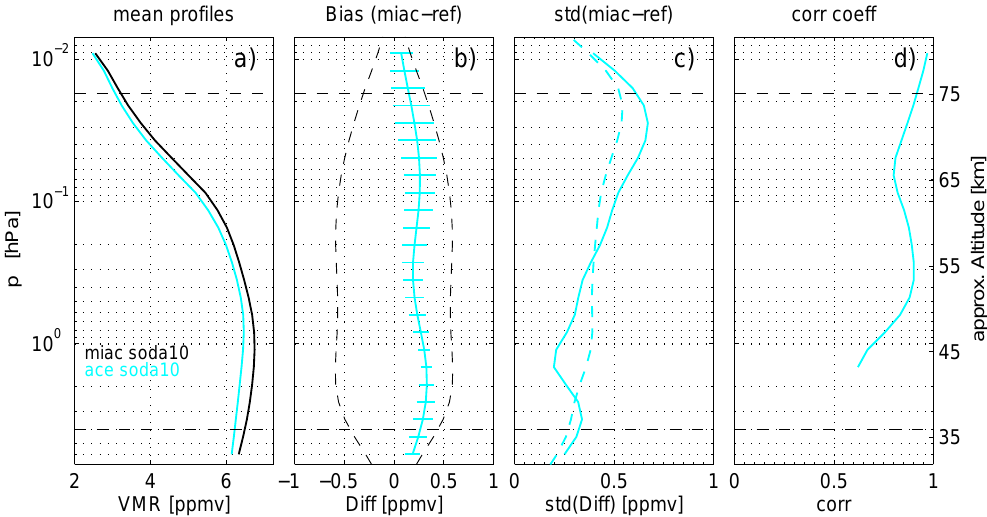
Fig. 13. Intercomparison MIAWARA-C – ACE-FTS for Sodankyl¨a10. (a) Mean coincident profiles of ACE-FTS (cyan)/MIAWARA-C (black) for 2010. (b) Bias (solid, cyan) and its standard error (horizontal) together with the estimated systematic error of MIAWARA-C (black dashed). (c) Standard deviation of differences (solid, cyan) and combined random error of the instruments (dashed). (d) Correlation coefficient. All plots use MIAWARA-C data with AoA > 0.5. The dashed horizontal lines indicate the reliable altitude range (AoA >